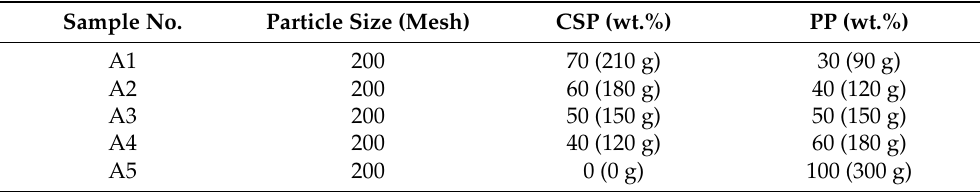
Figure 1. Schematic of possible coupling agent bridging interaction in the biocomposite. Table 1. The composition of biocomposite sample for 200 mesh coconut particle size. Sample